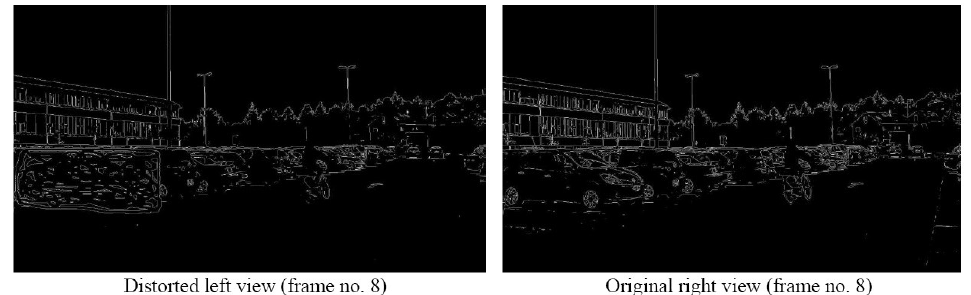
Figure 9. Sobel edge detection in a stereoscopic frame.